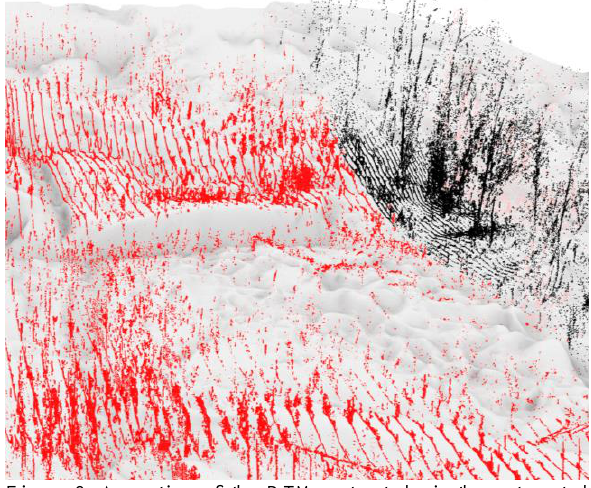
Figure 9. A portion of the DTM extracted via the automated method – software 3D